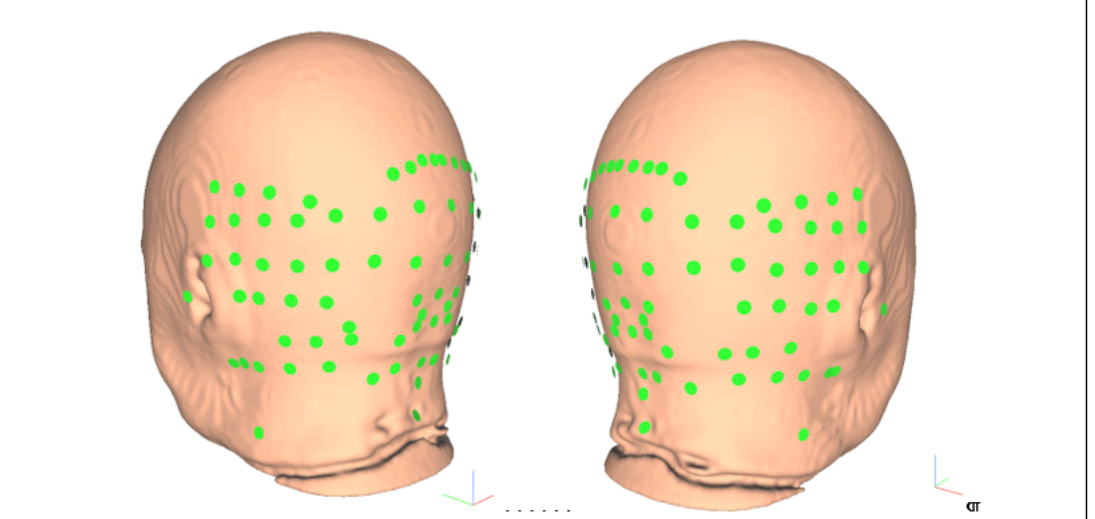
Figure 3. Reduced set of 87 electrode locations to optimize bipolar ctDCS montage for stroke survivors, namely: "E145", "E146", "E156", "E165", "Ex1", "Ex2", "Ex3", "Ex4", "Ex5", "Ex6", "Ex7", "Ex8",